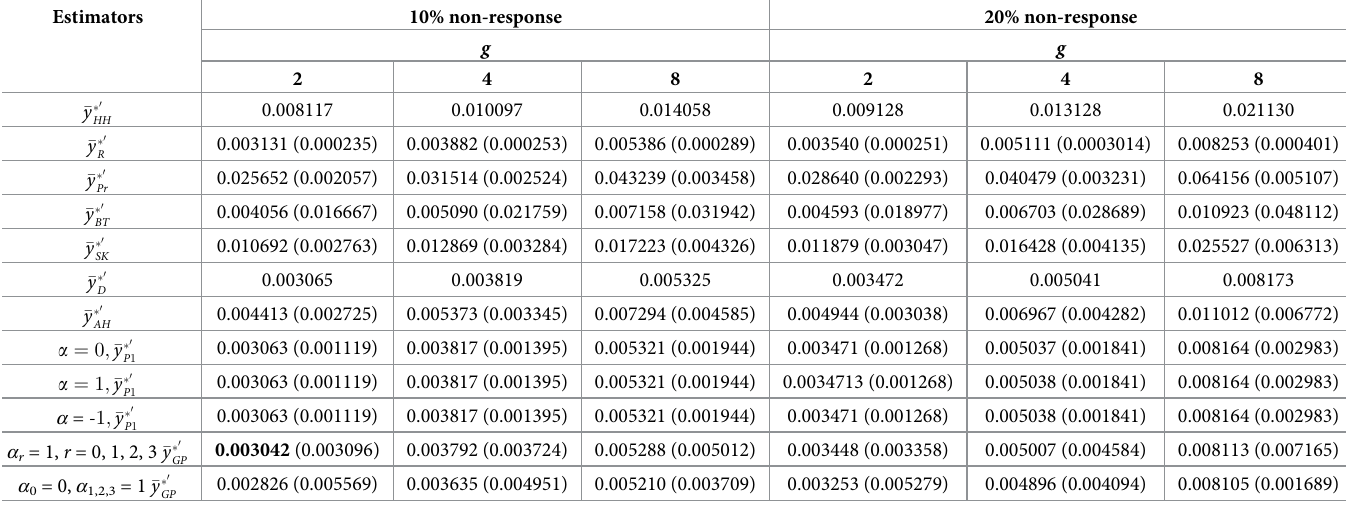
Table 10. Mean squared error and | Bias | (in brackets) values for different estimators for Population IV without measurement